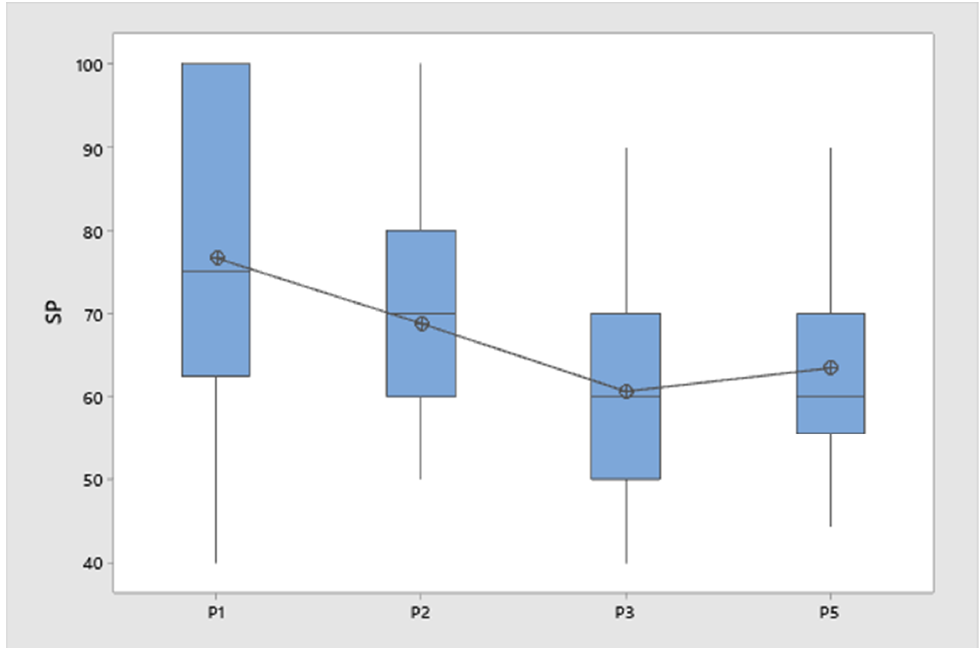
Figure 4. Box plot of four patterns showing SP means, medians, and interquartile ranges of observations.